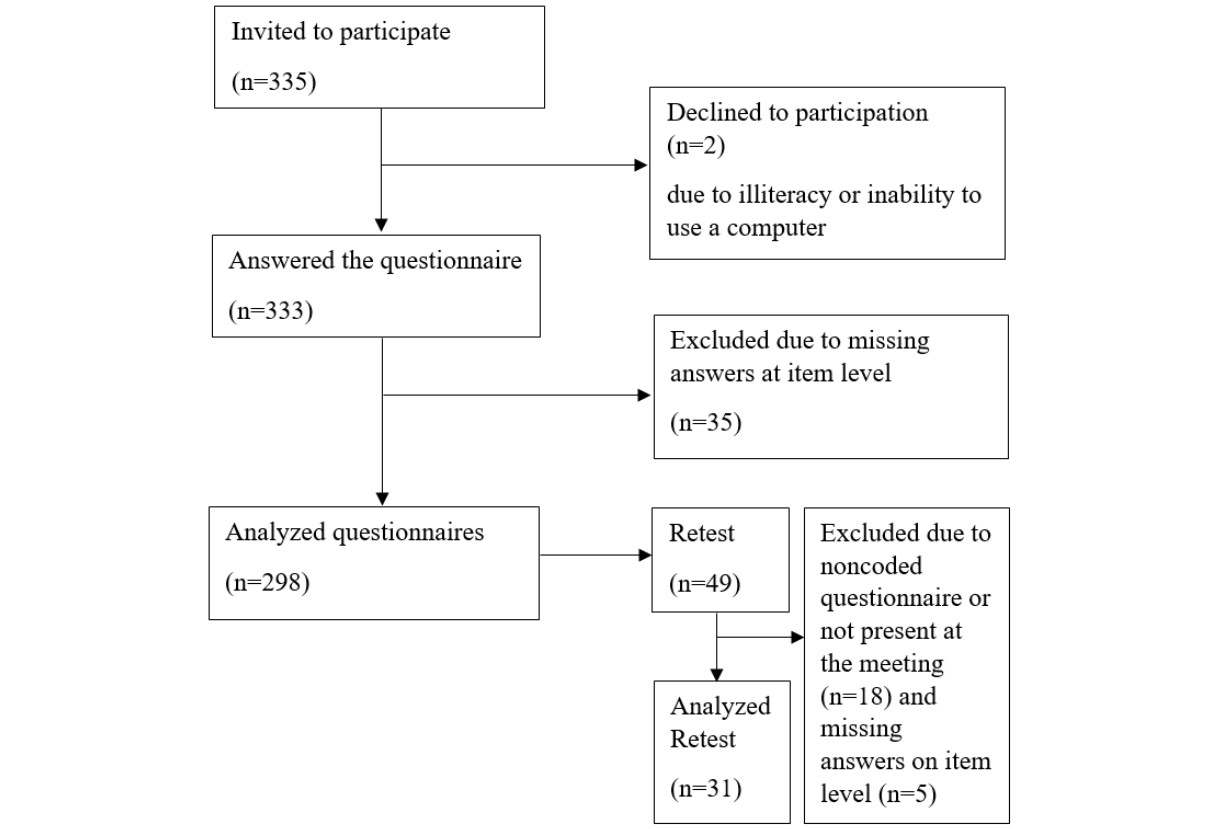
Figure 1. Data collection